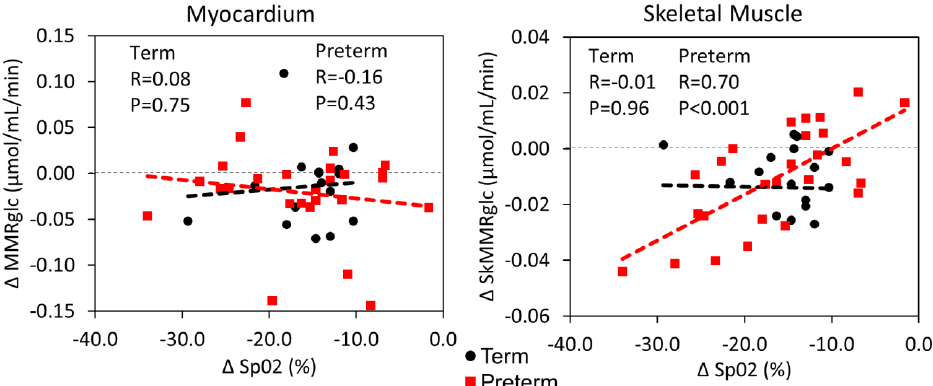
Figure 6. Correlation plots of the change in myocardial metabolic rate of glucose ( ∆ MMRglc; left graph) and the change in skeletal muscle metabolic rate of glucose ( ∆ SkMRglc; right graph) vs. the change in peripheral oxygen saturation ( ∆ SpO 2 ) with hypoxia. Each graph also lists the Pearson correlation coefficient (R) and the p -value for the relationship between the variables from univariate linear regression in each group.